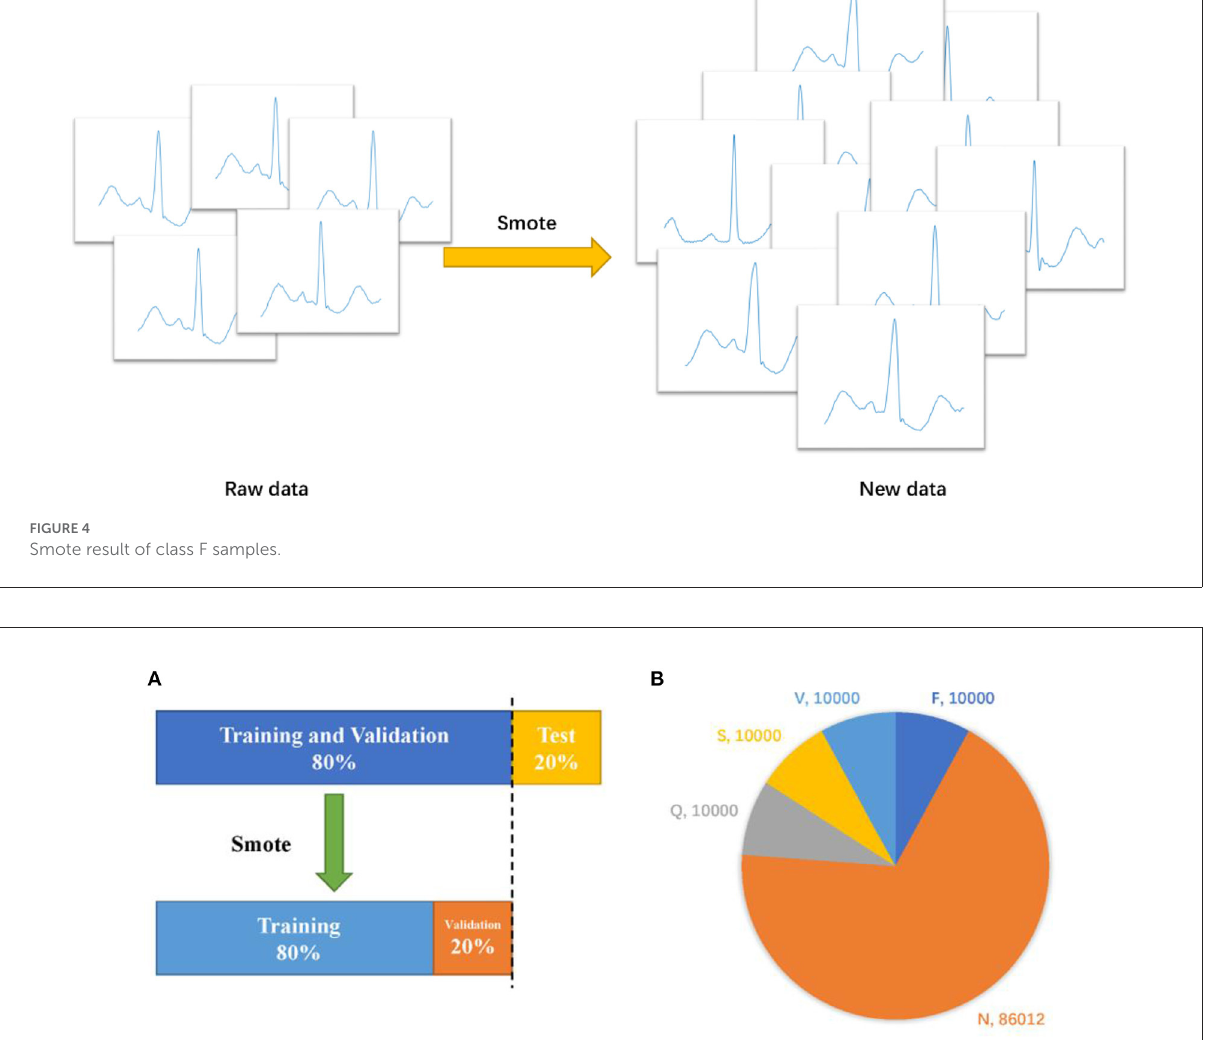
FIGURE5 Dataset division strategy (A) and the quantity of samples before and after augmentation (B)